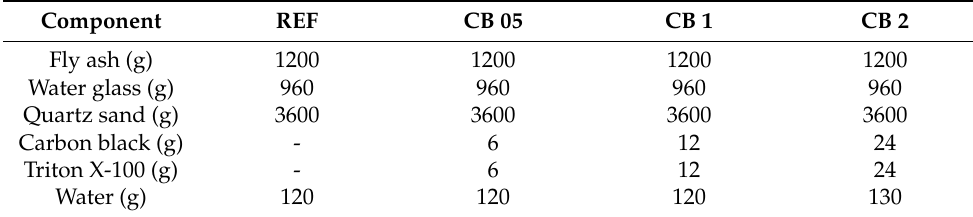
Table 2. Composition of the